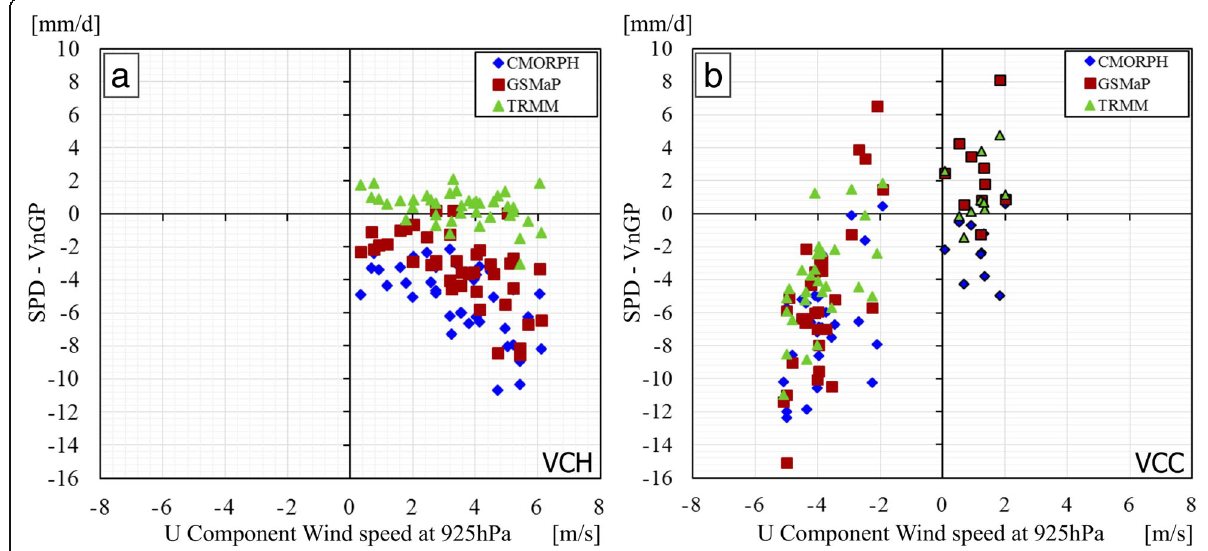
Fig. 12 Scatter plots between the zonal wind component at 925 hPa (abscissa, unit m s − 1 ) in the ERA interim and rainfall difference Δ P (SPDs rainfall minus the VnGP rainfall; ordinate, unit mm day − 1 ) averaged for each region and each month during MJJA in the VCH ( a ) and SOND in the VCC ( b ) from 2001 to 2010. N = 40 for each plot, black-bordered marks show the values in September